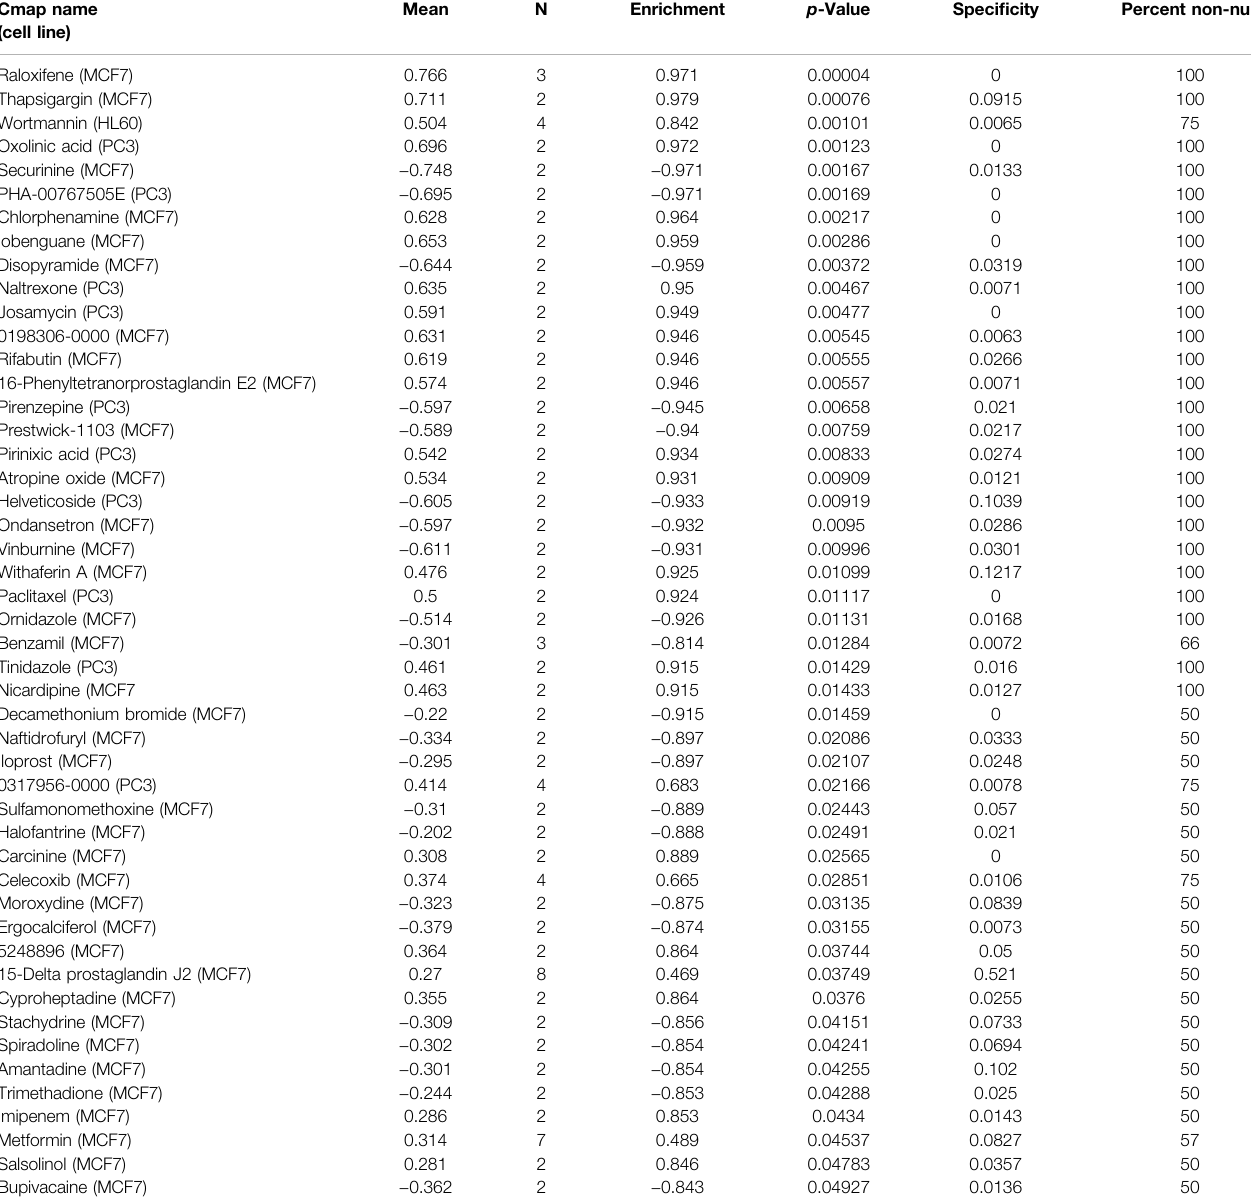
TABLE 3 | Prediction of potential small molecule agents based on the TSG-based prognostic classi fi er by connectivity map (CMap). Cmap name (cell